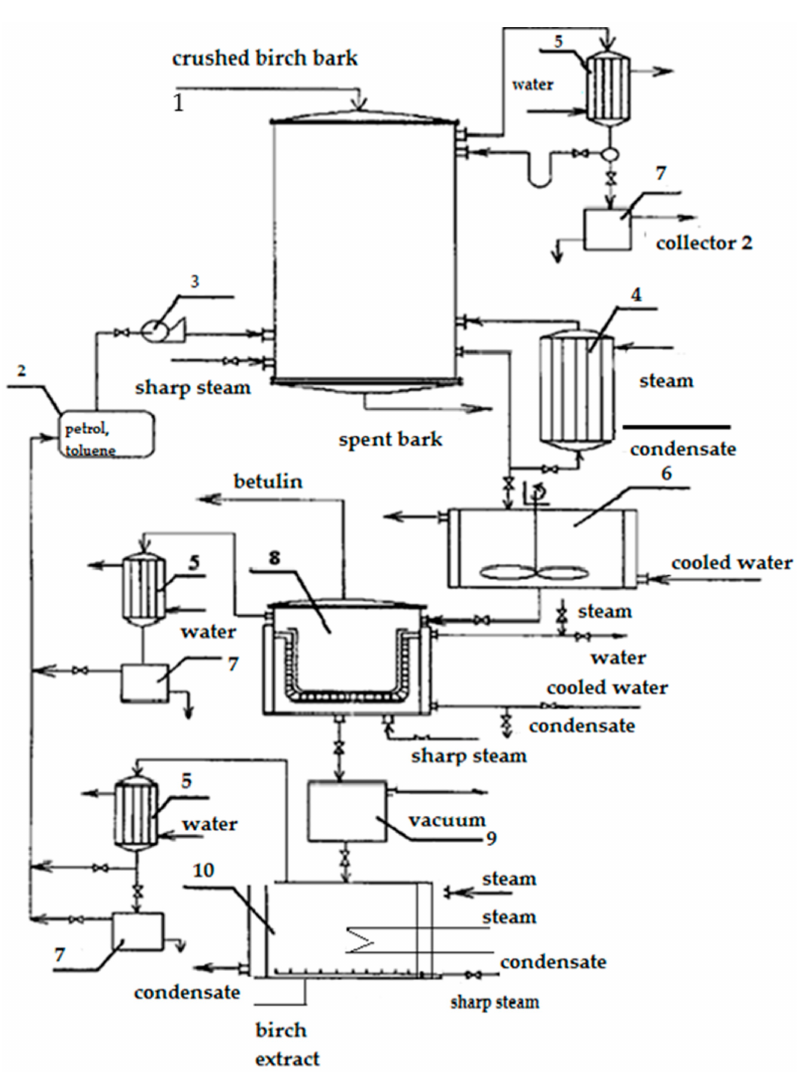
Figure 3. Typical technological process of betulin production. The crushed birch bark is loaded into the extractor (1), where a solvent is fed from the collector (2) by a pump (3), which is heated in the heater (4). Solvent vapors condense in the refrigerator (5), and the duration of extraction is 5–6 h. After extraction, the hot extract is poured into the crystallizer (6), the solvent residues are driven away from the bark with sharp steam, the solvent is separated in florentine (7) and enters the collector (2). The crystallizer is equipped with a stirrer and a cooling jacket in various designs. After cooling, the extract is fed to a vacuum nutch filter (8), and the filtrate goes through an intermediate receiver (9) for evaporation into the evaporation apparatus (10). At the final stage, the solvent is removed from the precipitate by sharp steam